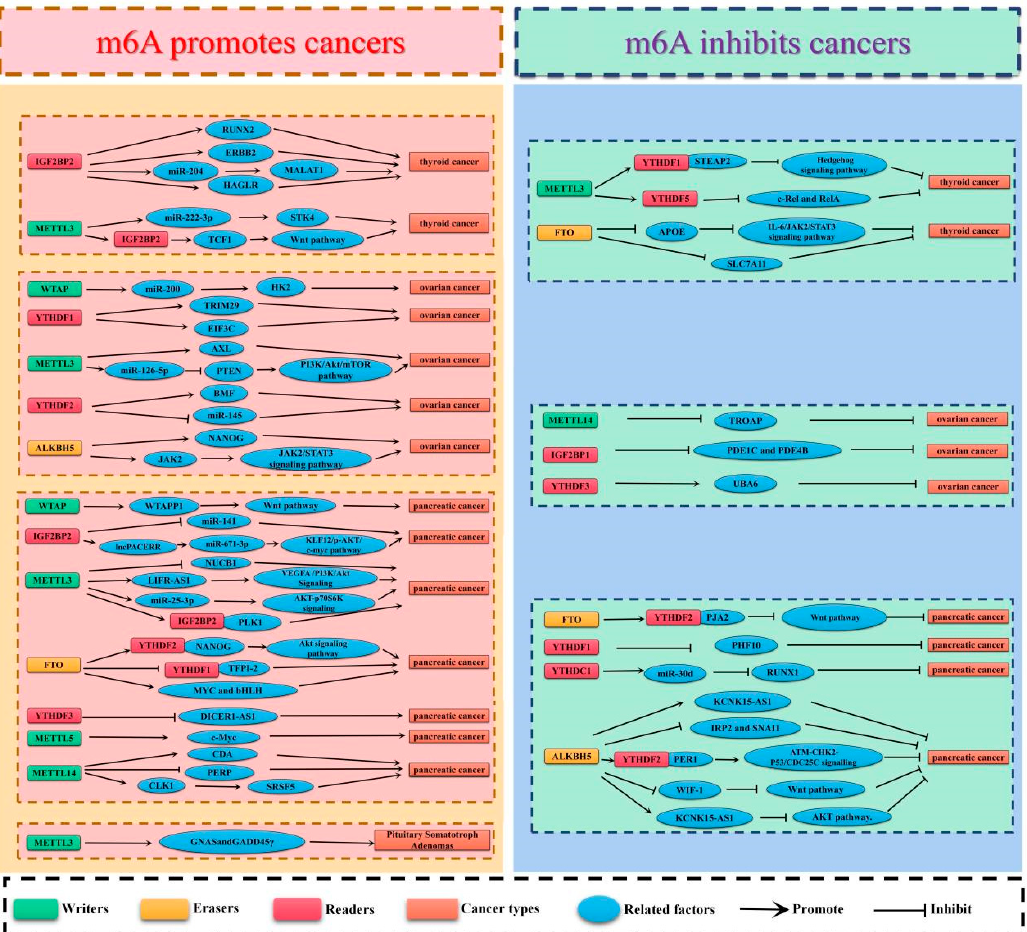
Figure 2. The potential roles of m6A in endocrine cancer progression. The potential role of m6A in endocrine cancer progression is reflected in the regulation of tumor-associated gene expression. m6A modification promotes cancer progression by enhancing oncogene expression and inhibiting tumor suppressor gene expression. m6A modification hinders cancer progression by inhibiting oncogene expression and enhancing tumor suppressor gene expression.